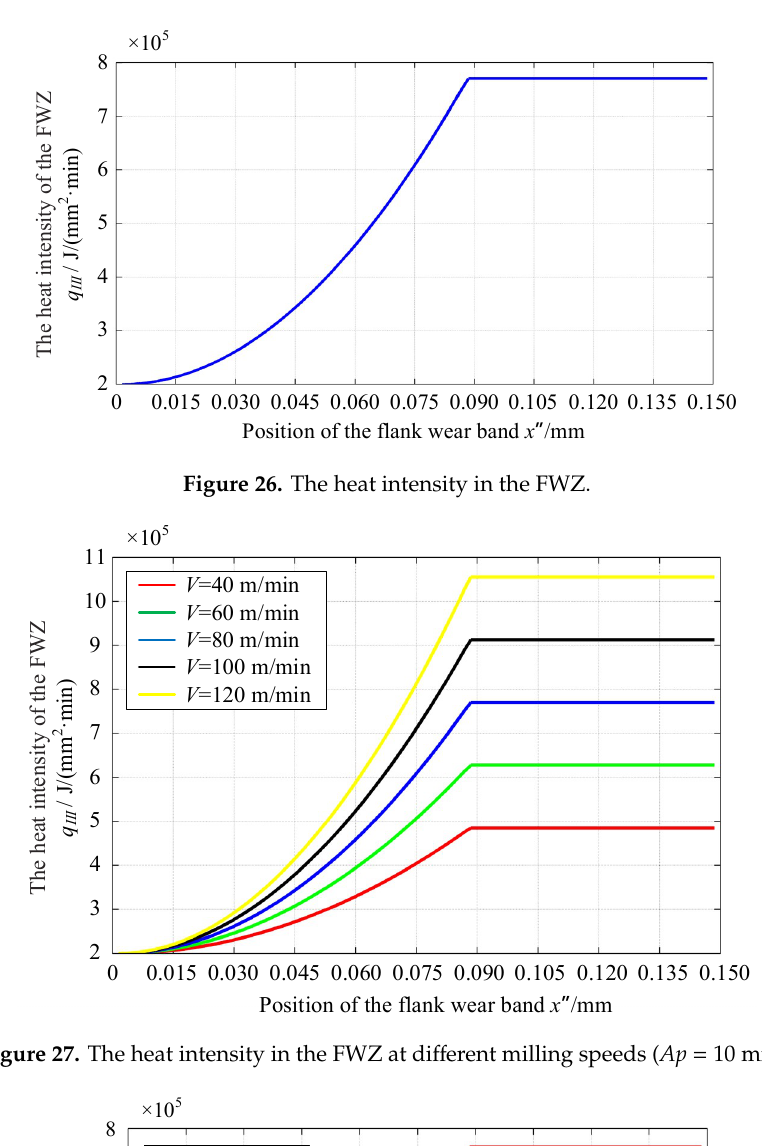
Figure 27. The heat intensity in the FWZ at different milling speeds ( Ap = 10 mm).